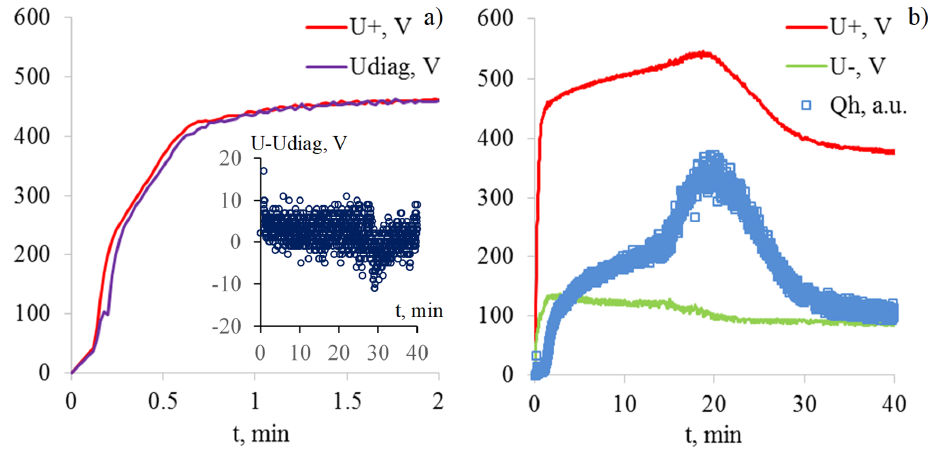
Figure 13. Initial period of anodic voltage (U+) of PEO process under current control, producing a pulse train and a self-tuning diagnostic pulse amplitude (Udiag) ( a ). The inset illustrates the discrepancy U–Udiag within the entire process. Evolution of the positive and negative voltage amplitudes and the hysteresis charge ( b ).